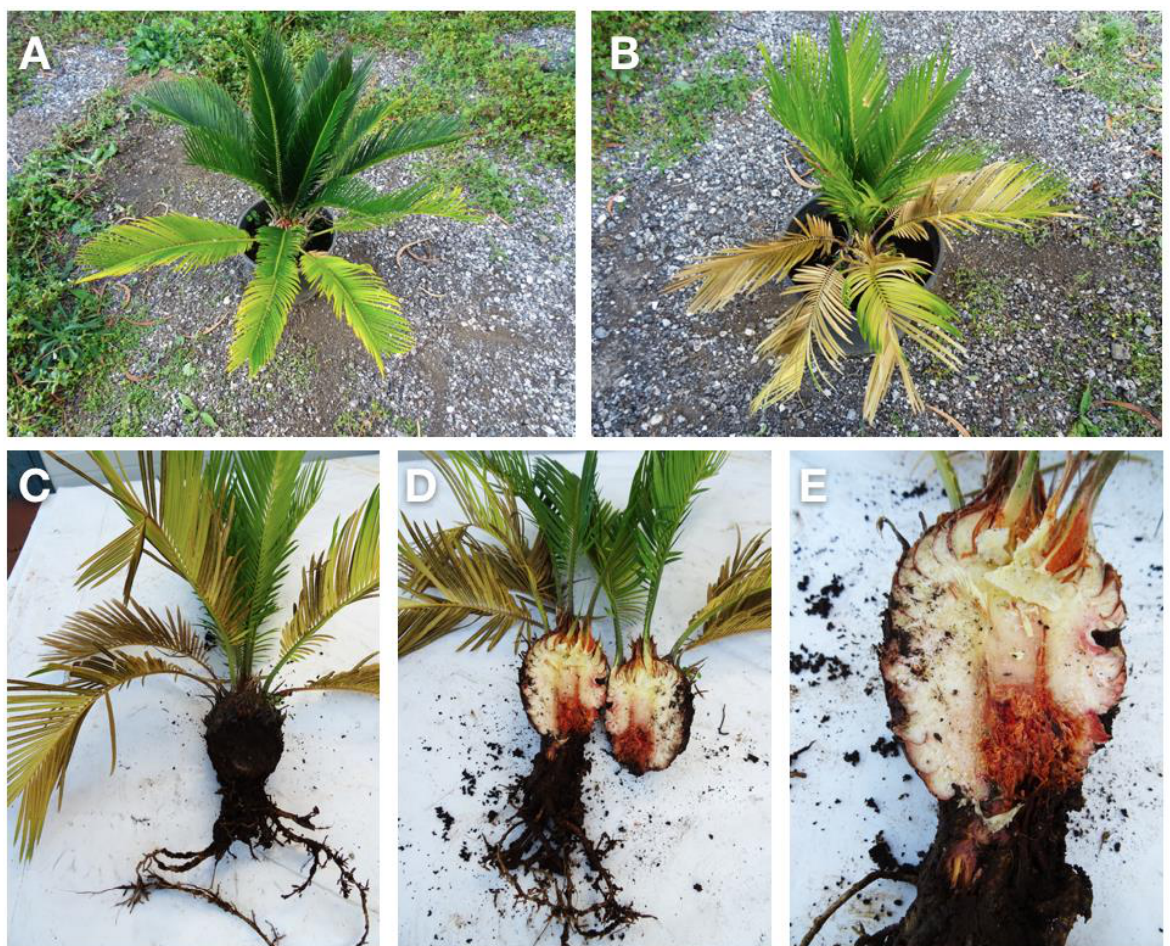
Figure 1. Symptoms of chlorosis, ( A ) followed by desiccation ( B ) of the older leaves and root rot, associated with the internal browning of the subterranean stem on three-year-old potted sago palm plants ( C – E ).